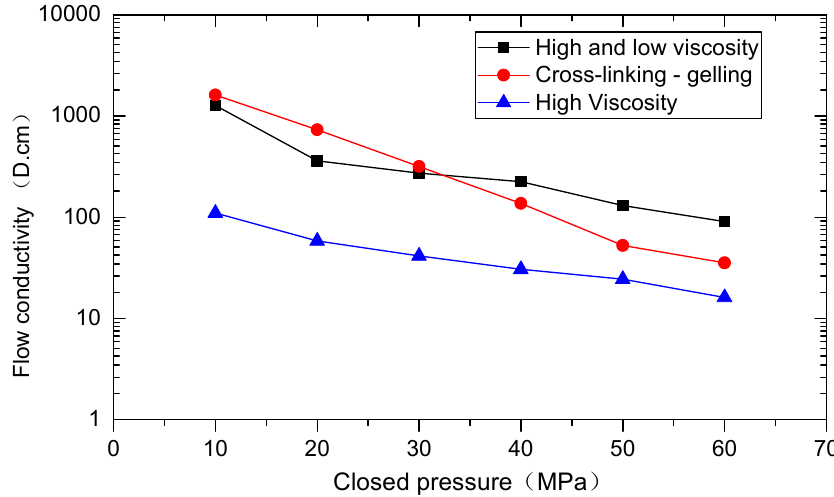
Figure 12. Conductivity of fracture-dissolved pore reservoirs under different closing pressures.